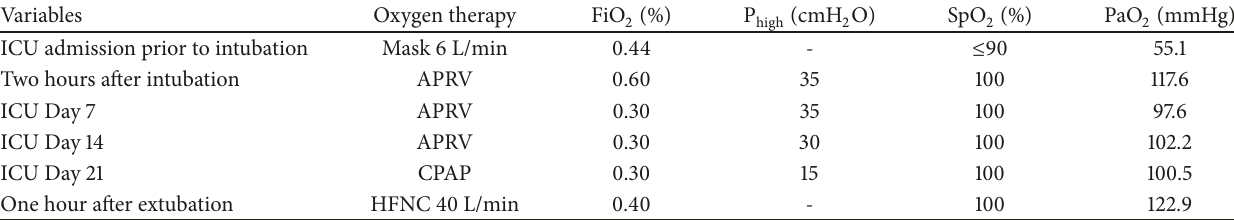
Table 1: Respiratory and hemodynamic parameters from hospital admission to ICU